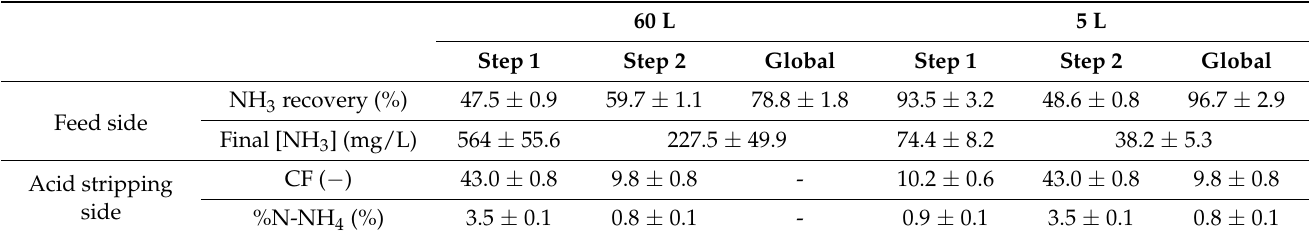
Table 3. Results of the study of the feed volume